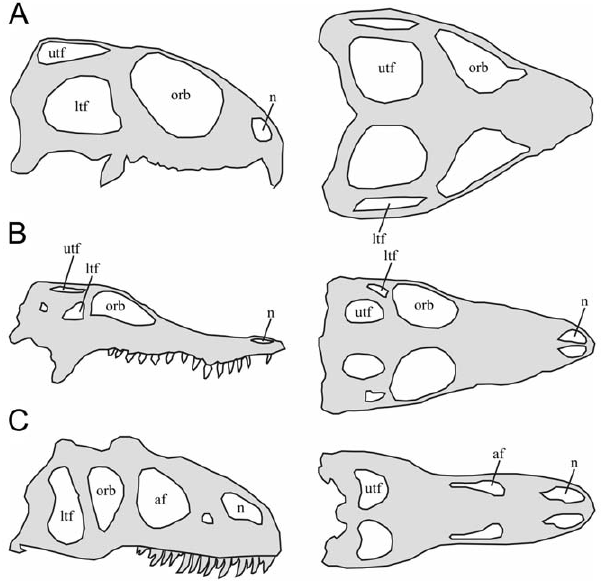
Figure 1. The diapsid skull form. Simplified schematic lateral and dorsal skull views of A. Sphenodon (redrawn [87]), B. Crocodylus siamensis (original drawing), C. Allosaurus fragilis (redrawn [92]). All skulls are scaled to the same length. af – antorbital fenestra; ltf – lower temporal fenestra; n – nasal opening; orb – orbital opening; utf – upper temporal fenestra.